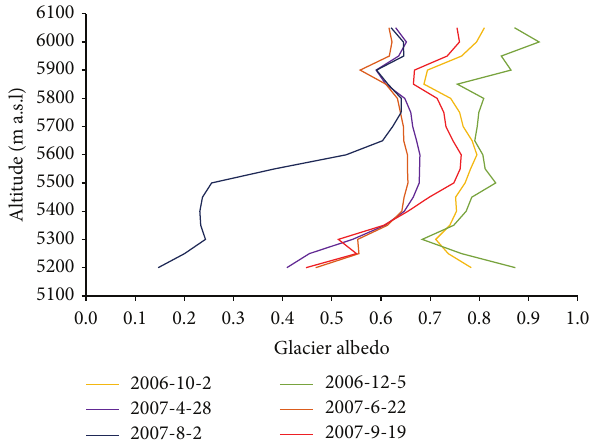
Figure 5: Albedo variations with altitude for the different seasons in the period of